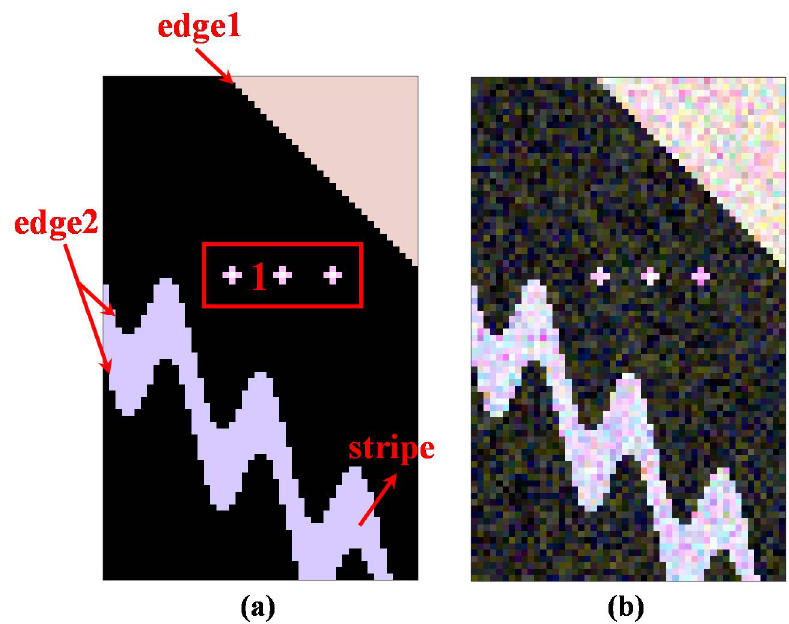
Figure 4. The Pauli basis composite RGB images. ( a ) Noise-free image. ( b ) Simulated image. The four marked areas are used for the subsequent quantitative evaluation of the denoising performance.